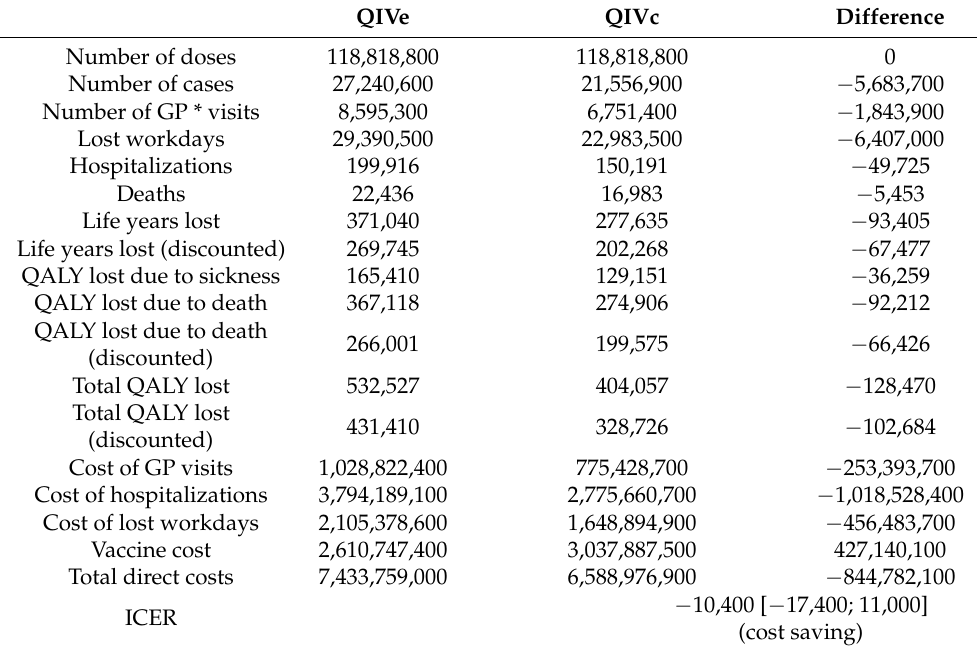
Table 2. Base case result—3 years of mismatch out of 5 years. The 3 years of mismatch considered are the 3 most recent influenza seasons. QIVe QIVc